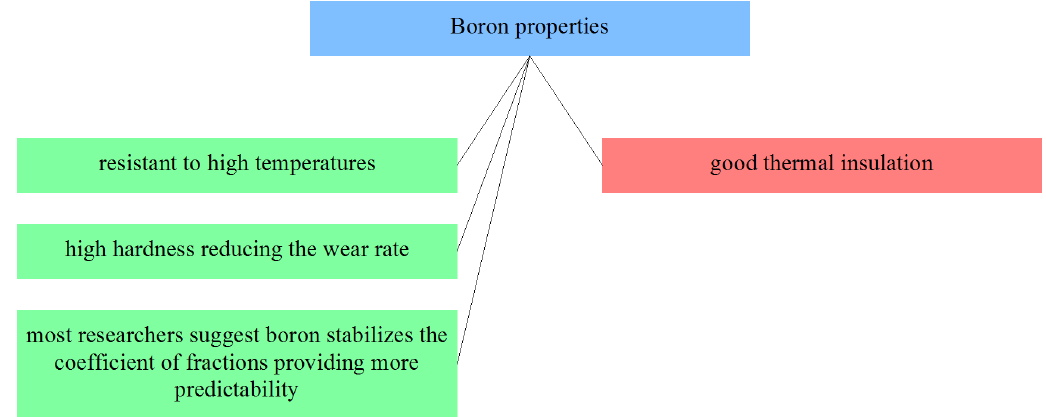
Figure 22: Selected boron composites properties from the point of view of applicability in friction